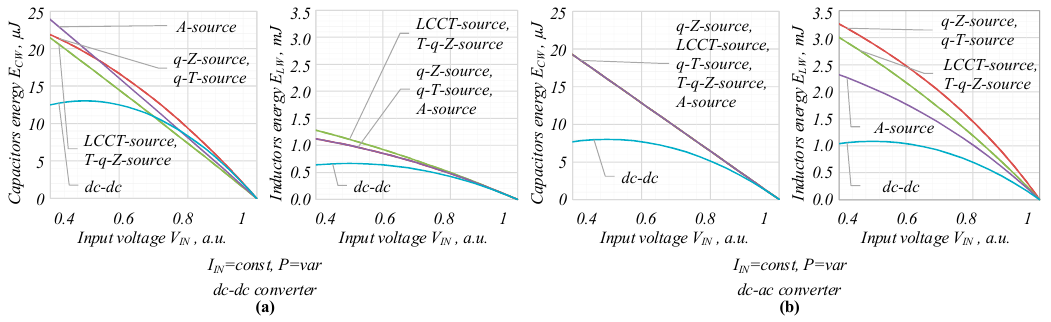
Figure 6. Energy stored in the passive components in ( a ) the dc-dc converter and ( b ) the inverter.